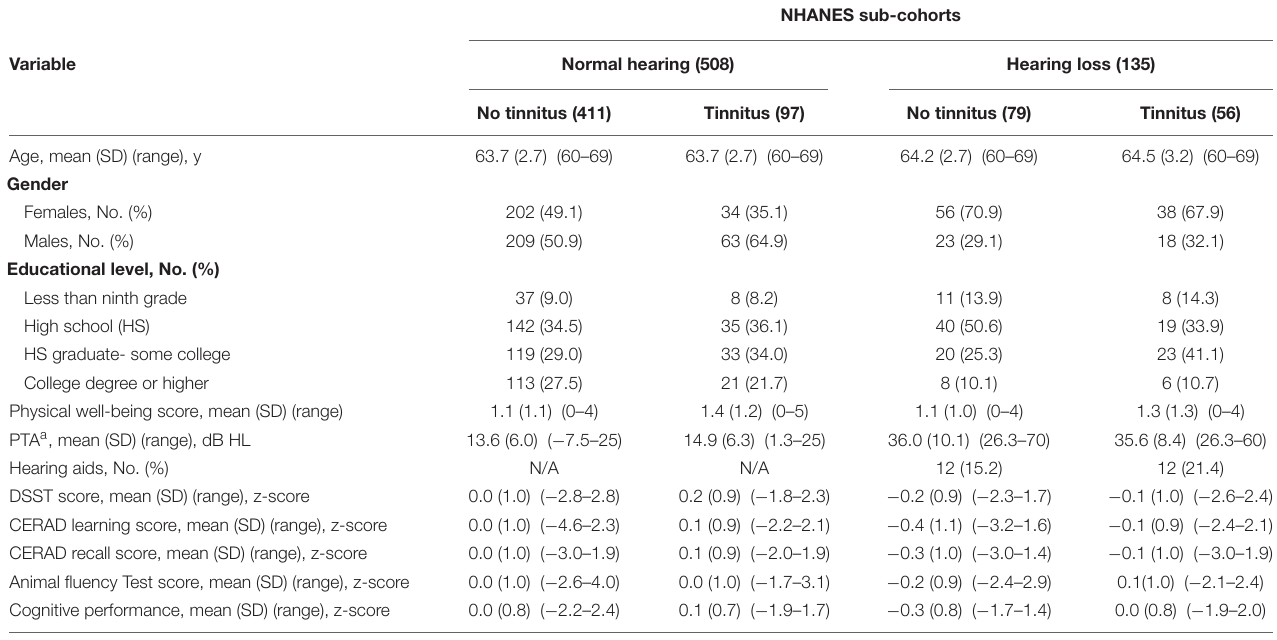
TABLE 2 | Participant characteristics and test scores of the NHANES sub-cohorts.